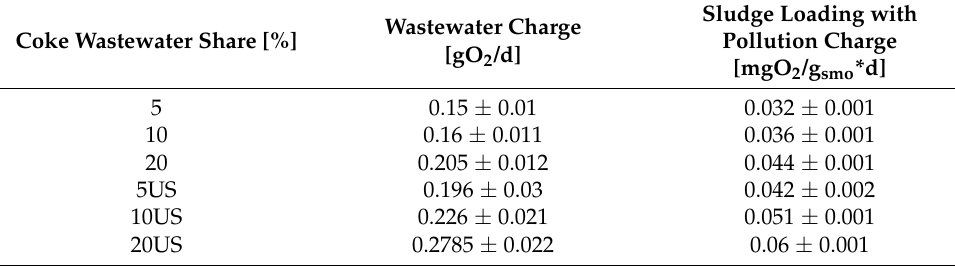
Table 5. Reactor’s operating parameters for individual percentage additions of coke wastewater.